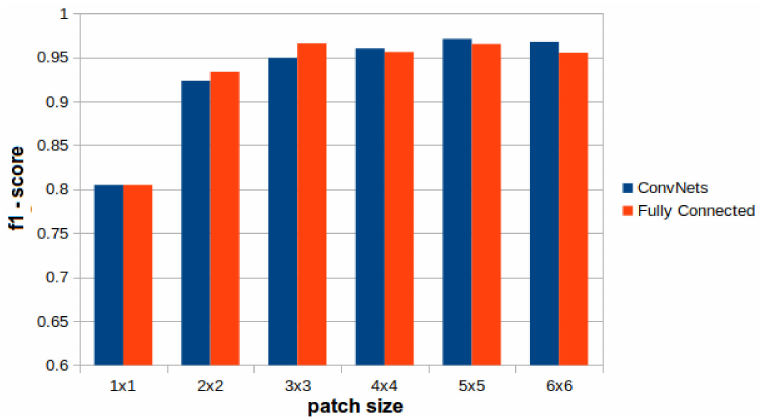
Figure 13. Bar graph of F1-score vs. the patch size.